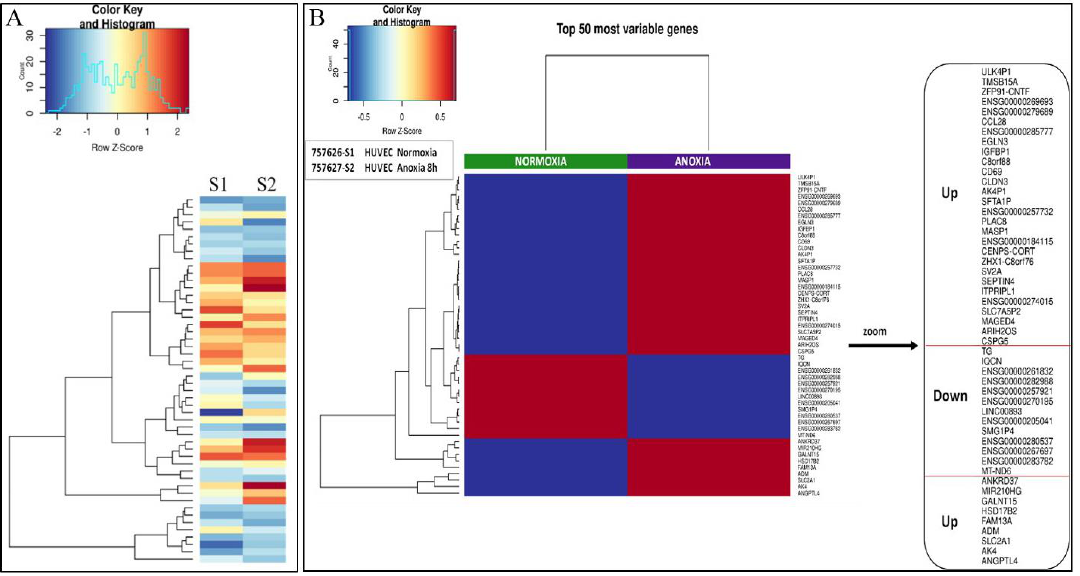
Figure 3. RNA−seq analysis of mRNA expression in HUVEC cells maintained in normoxia ( S1 ) or anoxia ( S2 ). ( A ) Heatmap generated from transcriptome analysis of S1 vs S2. ( B ) List of the 50 most variable genes involved in cellular responses differentially expressed in anoxic (S2) versus normoxic (S1) samples. Red color means upregulated genes; blue color means downregulated genes.